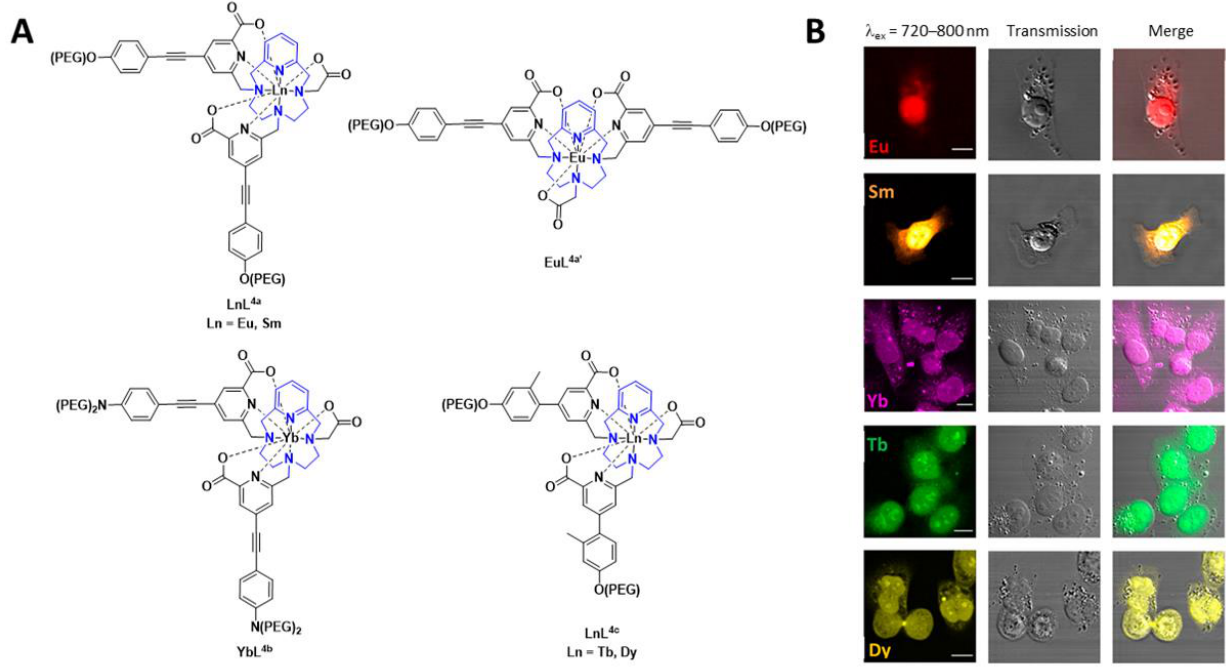
Figure 5. ( A ) Chemical structures of lanthanide-based probes containing pyclen ligands. ( B ) Left: 2P imaging of paraformaldehyde-fixed T24-cells: [EuL 4a ], [SmL 4a ] (λ ex = 750 nm), [YbL 4b ] (λ ex = 800 nm), [TbL 4c ] and [DyL 4c ] (λ ex = 720 nm). Middle: transmitted light DIC images. Right: merged images. Reprinted (adapted) with permission from Ref. [52]. Copyright 2020 American Chemical Society.